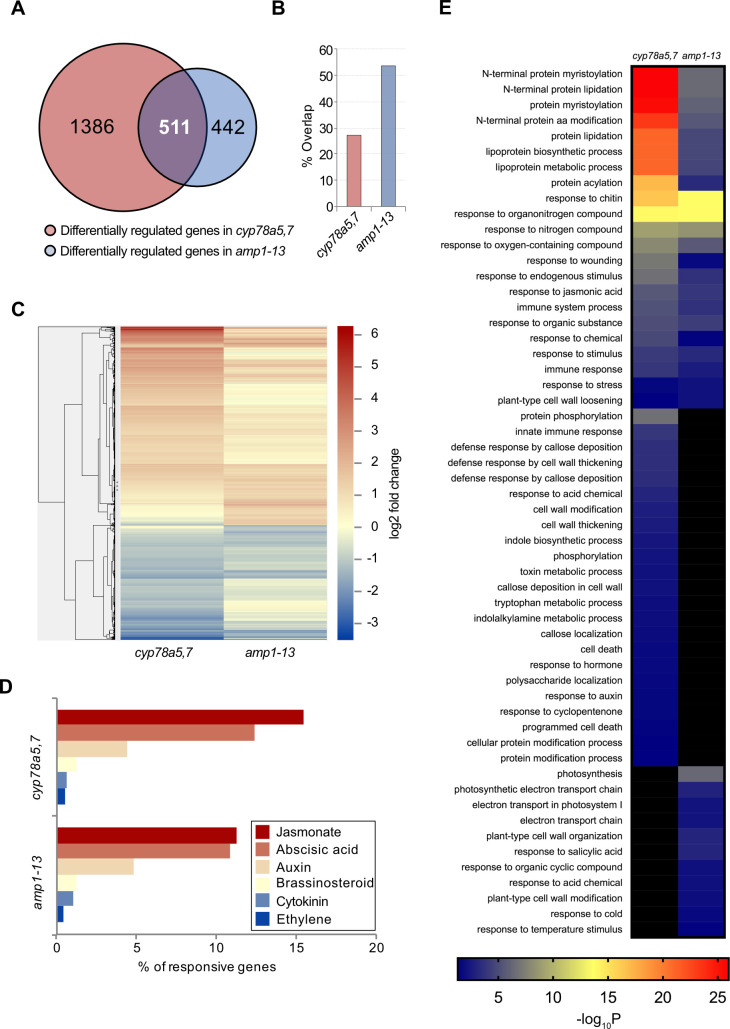
Comparative analysis of cyp78a5,7 and amp1-13 transcriptomic responses.A) Venn diagram showing the number of genes that were differently regulated in cyp78a5,7 and amp1-13 seedlings in comparison with Col-0. B) Graphical representation of the overlapping portion of differentially regulated genes in amp1-13 and cyp78a5,7. (C) Heat map of genes differently regulated in cyp78a5,7 and amp1-13 (2339 DEGs). The heat map was produced by clustering the normalized values using the hierarchical clustering algorithm implemented in Gene Cluster (Euclidean distance and Average linkage). The results were visualized using TreeView3. (D) Graph showing the fractions of hormone-specific marker genes differently regulated in cyp78a5,7 and amp1-13. (E) GO term enrichment analysis of genes differently regulated in cyp78a5,7 and amp1-13 (2339 DEGs).